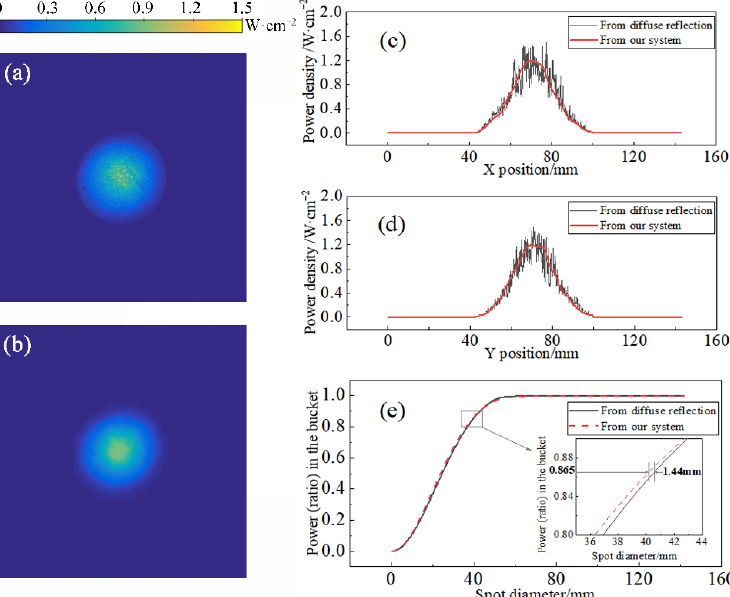
Figure 5. ( a ) Actual spot collected by the diffuse reflection screen; ( b ) spot measured by the system; ( c ) centroid section lines of the two types of spots in the x ‐ direction; ( d ) centroid section lines of the two types of spots in the y ‐ direction; ( e ) PIB curves of the two types of spots.